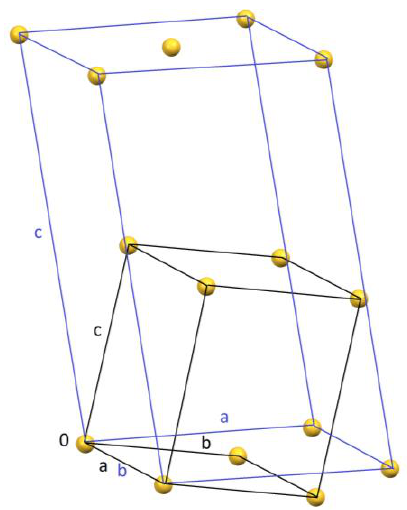
Figure 2. The relation between triclinic (black lines and letters) and monoclinic (blue lines and letters) unit cells. Origin is the same, small yellow spheres are the lattice points.